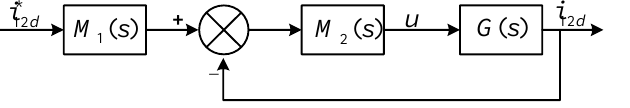
Figure 3. Block diagram of the first − order LADRC transfer function. When the first-order LADRC method is adopted, the transfer function is as shown in Equation (18). The control structure diagram of its d-axis is shown in Figure 4.The control method of split capacitor current feedback can make the current i 12 d between capacitors accurately track the given and does not contain the resonant sub-current, while there is a resonant pole in the closed-loop transfer function expression with i 2 d as the output, and the resonant sub-current component in the grid-connected current i 2 d will be large. In order to solve this problem, it can be considered to add a passive damping R d at the second capacitor C 2 d , which can effectively suppress the resonance in the grid-connected current.